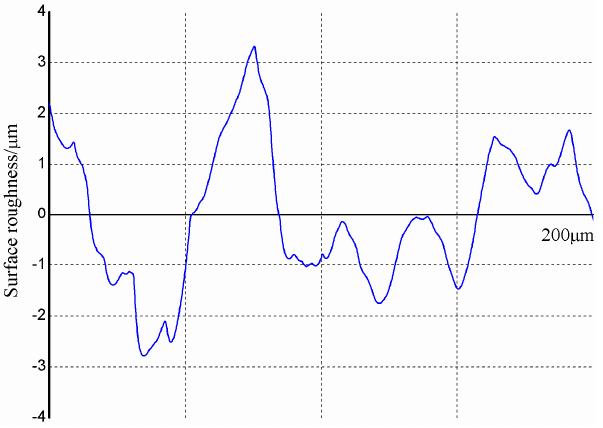
Figure 5. Surface roughness of the side wall in milled PDMS microchannels.